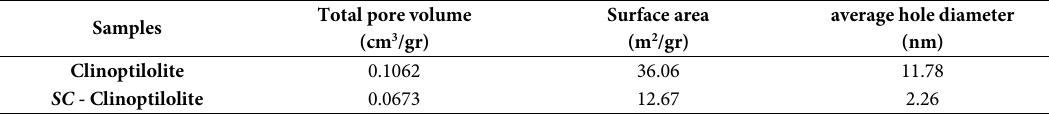
Table 3. Comparison of total pore volume and average pore diameter of clinoptilolite zeolite with modified zeolite